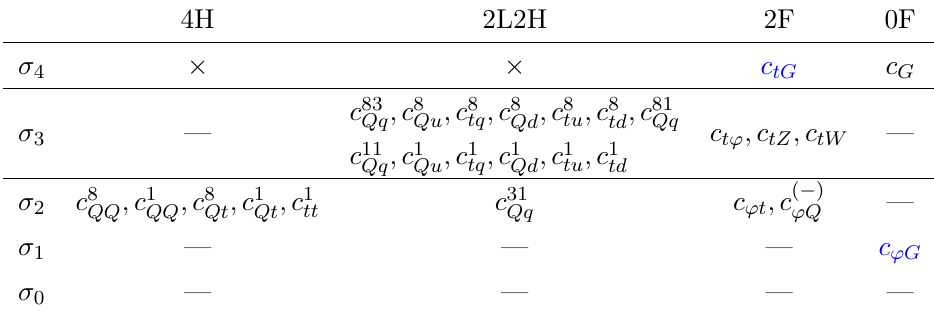
— — — Table 2 . Indication of the most significant contribution to the total cross-section of each operator √ at s = 13 TeV. Entries labelled × denote such coupling order is not allowed for the given class of operators. The blue colour denotes operators with contributions not only dominant at this given order in α s , but also other (higher or lower) orders in α s are significant enough that they can alter the total rate if not